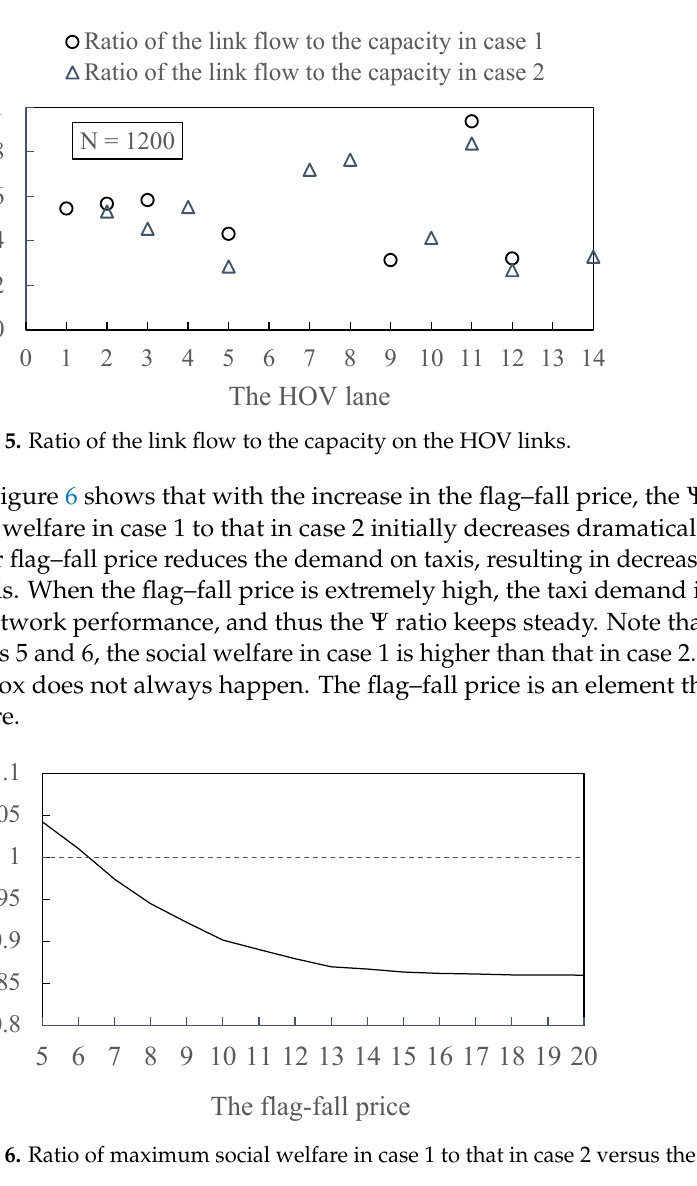
Figure 4. Ratio of maximum social welfare in case 1 to that in case 2 against various taxi fleet sizes.